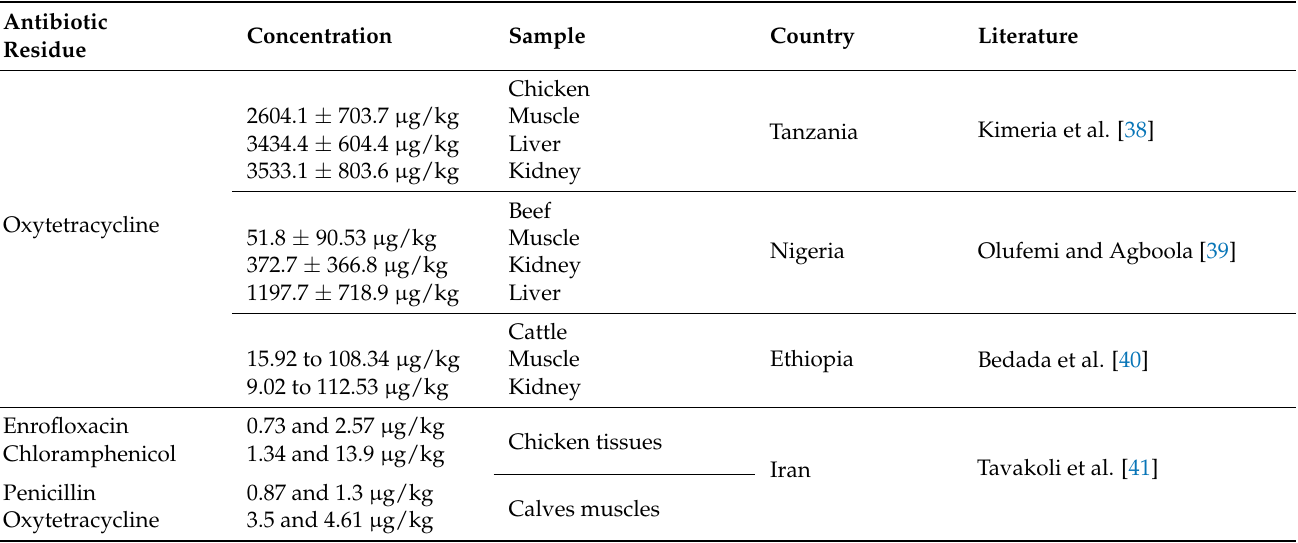
Table 2. Presence of varying concentrations of antibiotic residues in the different animal-derived products in some developing countries. Reprinted from